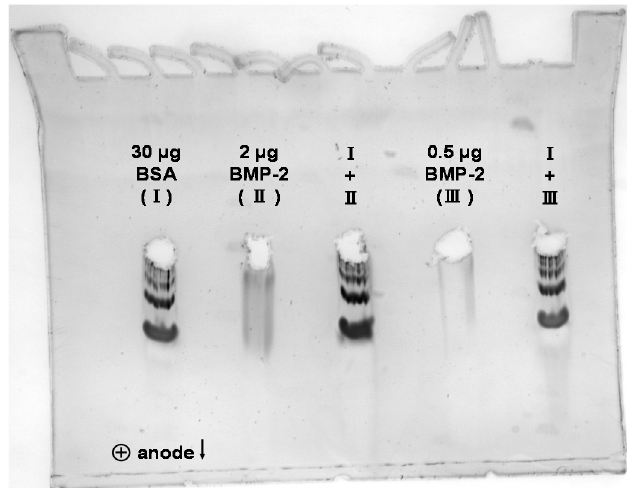
Figure 7. Silver staining after anodic native PAGE at pH 8.3 with proteins starting from drilled holes in the middle of the polyacrylamide gel.